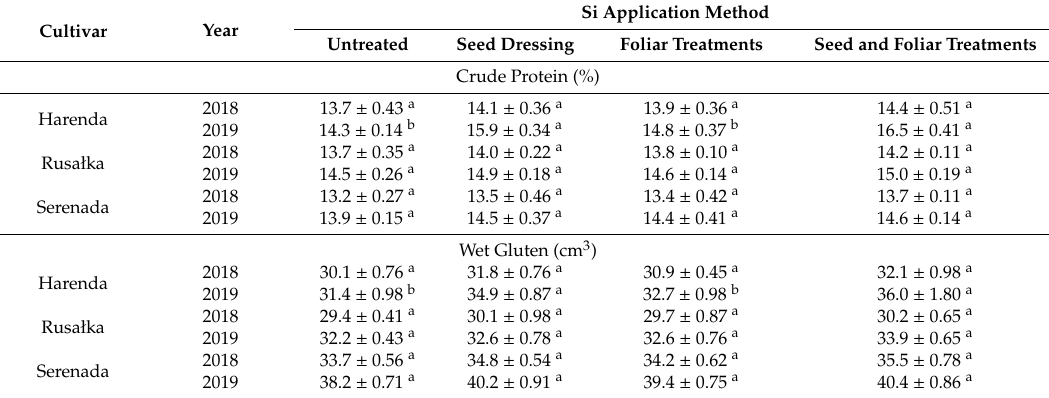
Values followed by the same letter are not statistically di ff erent at p < 0.05. Table 6. Selected parameters of wheat grain quality in relation to Si application method and wheat